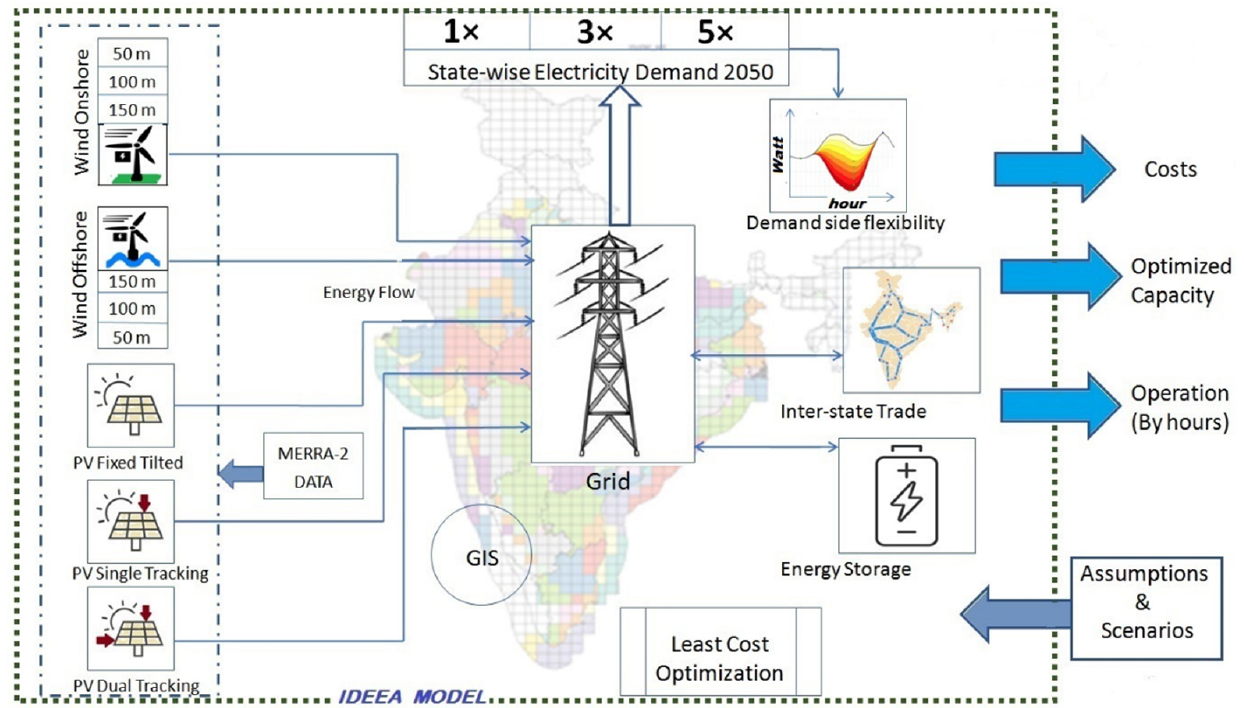
Figure 1. Schematic representation of IDEEA model structure and main functions.